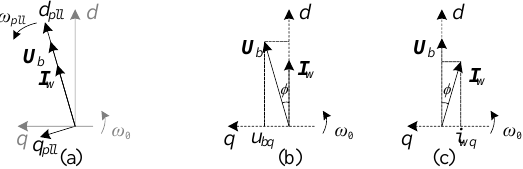
Figure 4. Vector diagrams in the rated synchronous reference frame (RSRF) under different control algorithms: ( a ) Conventional VC with i wq = 0; ( b ) Self-oriented control with i wq = 0; ( c ) Proposed Q - f control with u bq = 0.